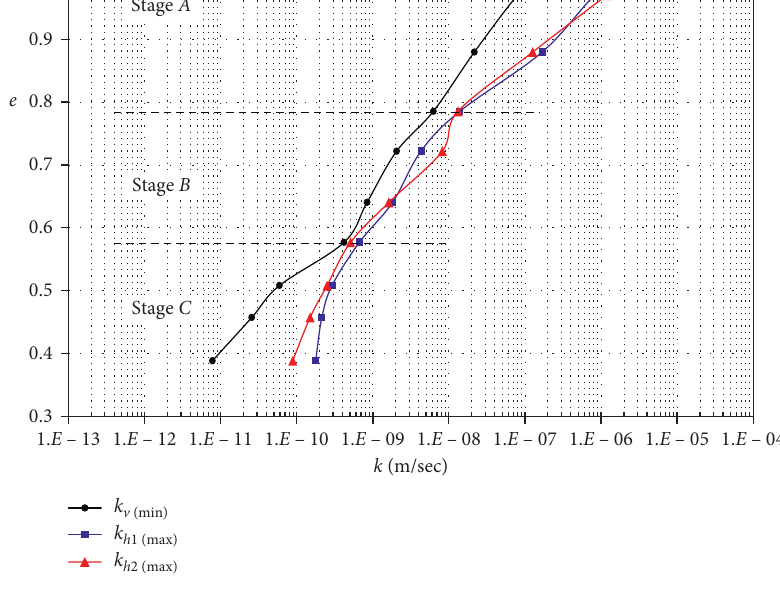
Figure 5: The k ( e ) graph for sample ΙΙ .